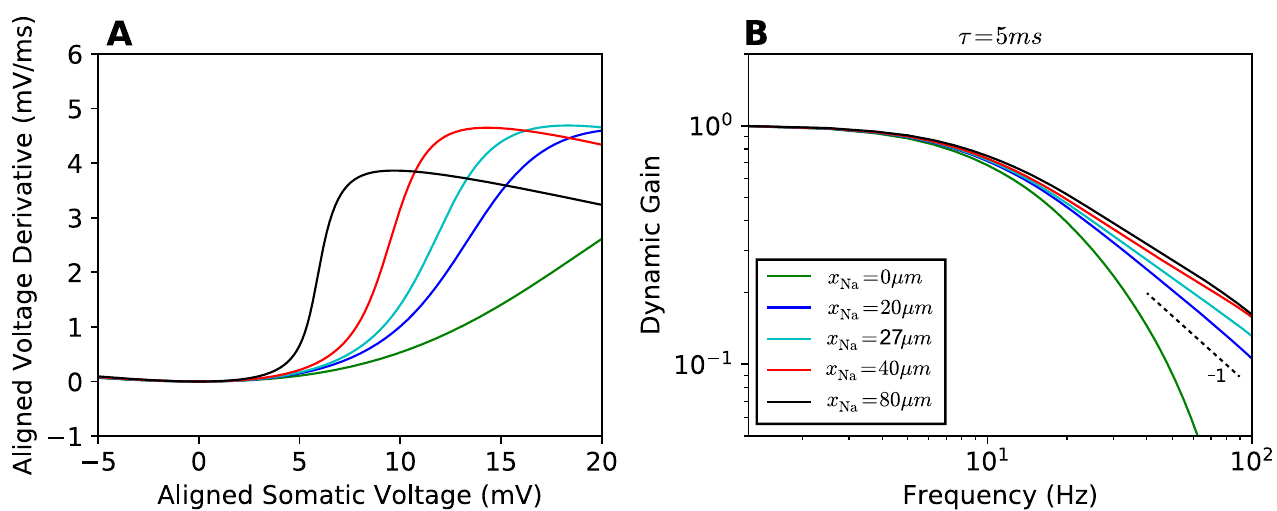
Fig 2. Phase plot and linear response functions. A Phase plots for the APs seen at the soma, somatic voltage rate of change vs. somatic voltage for different sodium channel positions x Na (legend in B ). The local minima of all curves are aligned at (0mV, 0mV/ms). B Dynamic gain functions for different x Na , normalized. 95% confidence intervals are plotted as shaded areas, mostly hidden by the line width. All curves are above statistical significance threshold (see Methods). The input current correlation time was set to τ =